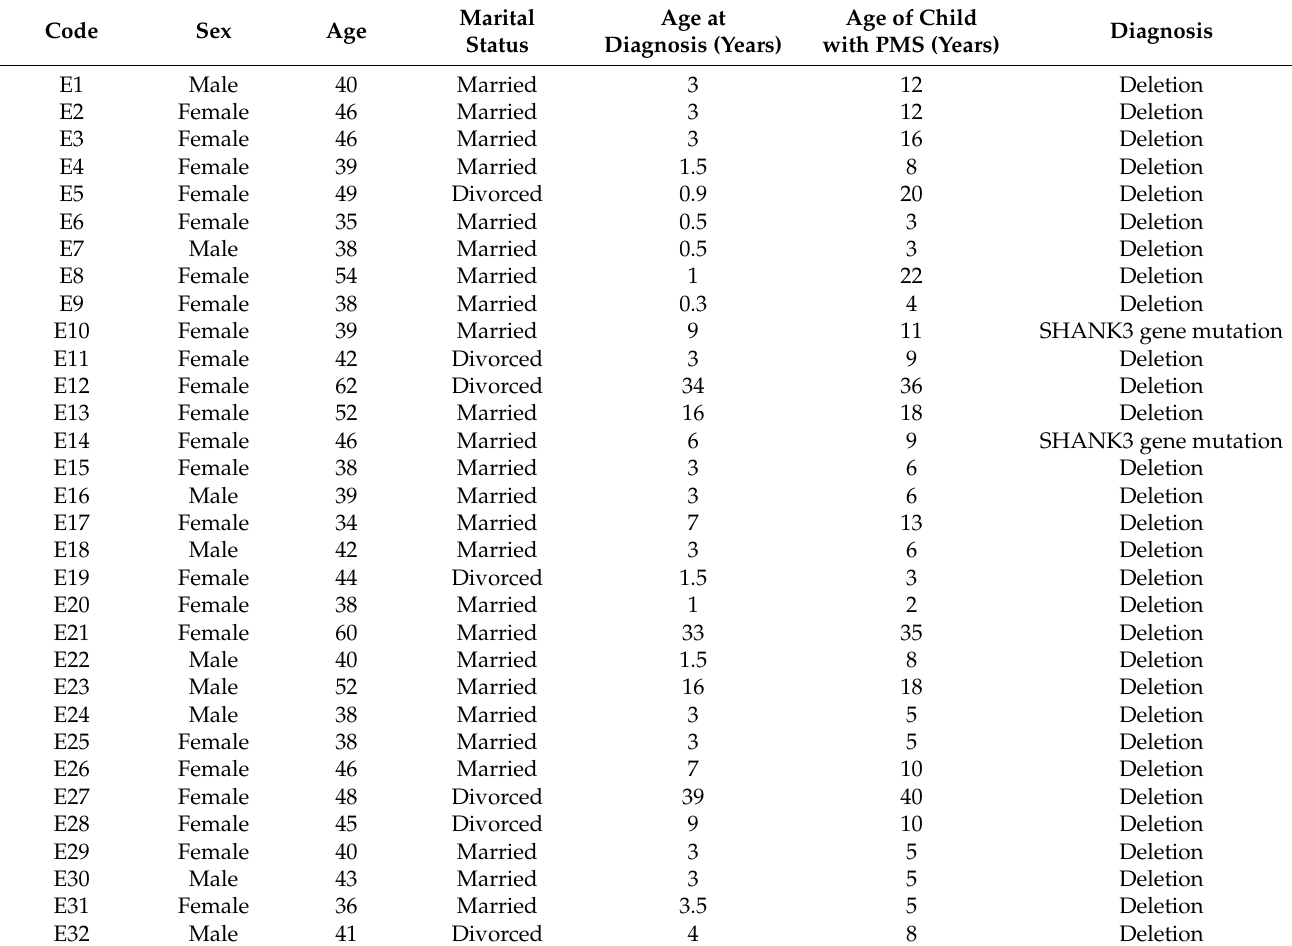
Table 3. Sociodemographic characteristics of each participant and clinical features their